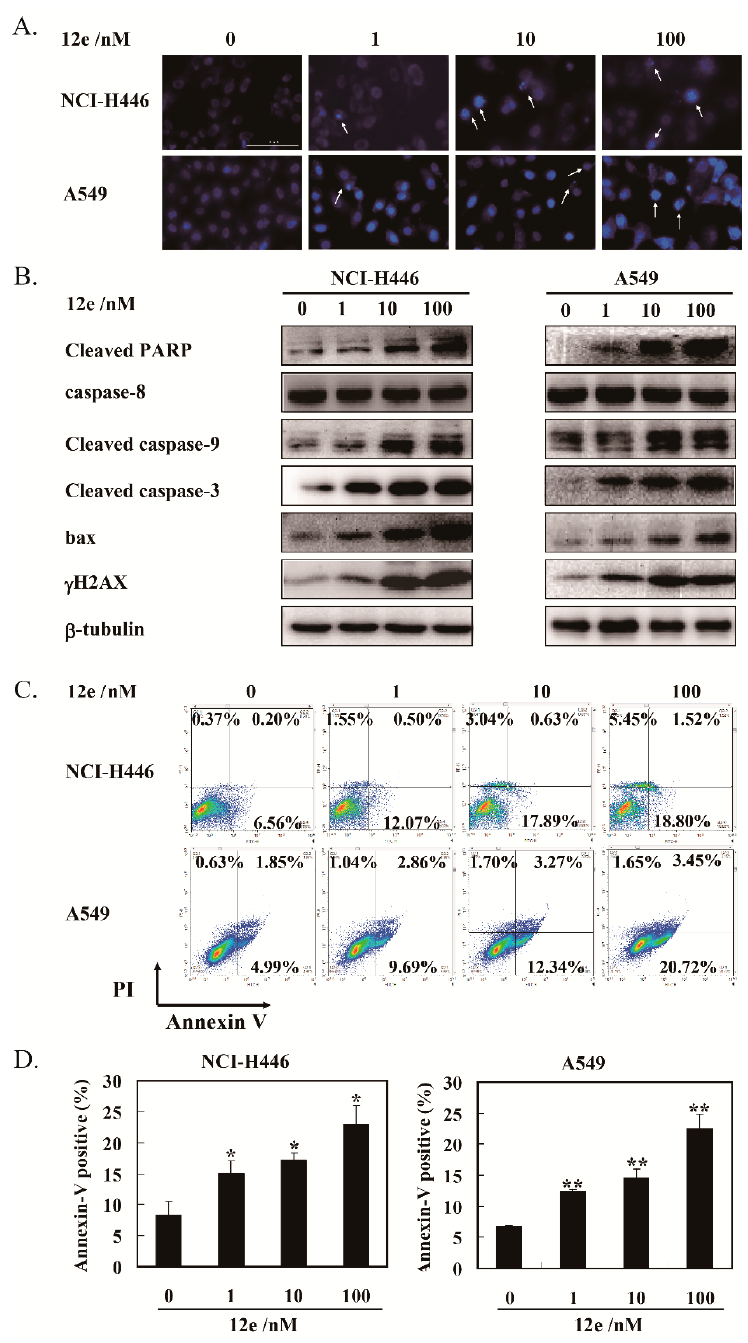
Figure 3. 12e promotes apoptosis of lung cancer cell lines. ( A ) NCI-H446 and A549 cells were treated with 12e (0–100 nM) for 24 h, then stained with Hoechst 33342, the photos were taken using microscopy (magnification, 200 × ). The brighter blue fluorescence (indicted arrows), show apoptotic cells. ( B ) Western blotting analysis of the expression level of apoptosis-related proteins in indicated cells after treated with 12e. β -tubulin was chosen as the internal control. ( C ) Apoptosis rate of cancer cells induced by 12e. Cells were treated with indicated concentrations of 12e for 24 h, then stained with Annexin V-FITC / PI, and determined by flow cytometry. ( D ) Quantification of the Annexin-V positive cells, * p < 0.05, ** p < 0.01 vs. control.